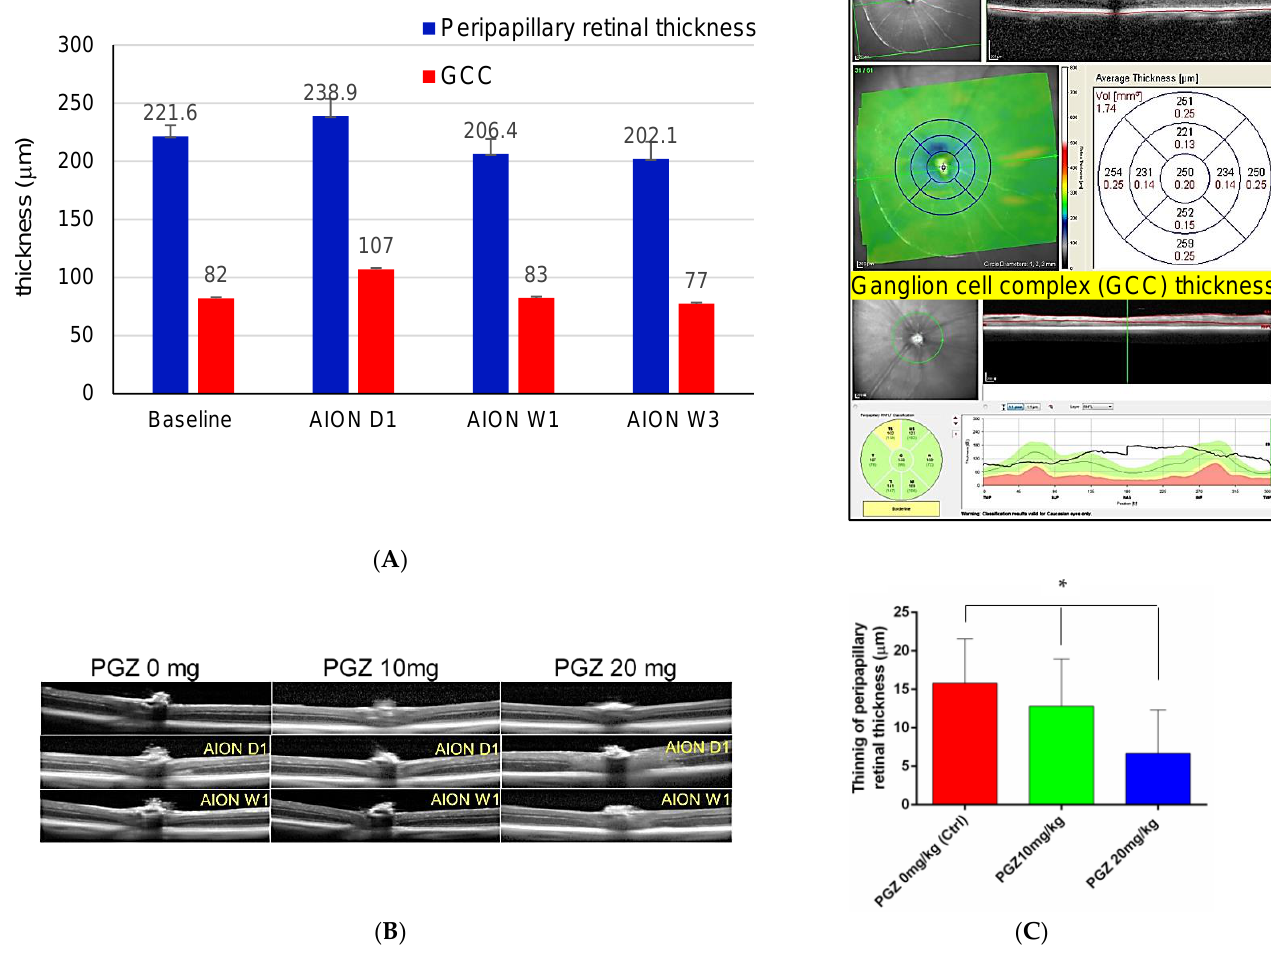
Figure 2. OCT measurement after AION in HFD feeding followed by STZ-induced diabetic mice. ( A ) Peripapillary retinal thickness using posterior pole scan and ganglion cell complex (GCC) thick- ness were measured through OCT on day 1 (AION D1), week 1 (AION W1), and week 3 (AION W3) in diabetic mice without treatment of PGZ ( n = 17). The thinning of peripapillary retinal thickness was more significant than (GCC) thickness at AION W1 and W3. The up-right figure showed how the OCT machine measured the peripapillary retinal thickness and GCC thickness. ( B,C ) Less retinal thinning of peripapillary retinal thickness at posterior pole scan on AION W1 was noted in DM mice treated with 20 mg/kg PGZ than in the other 2 groups ( * p < 0.05).